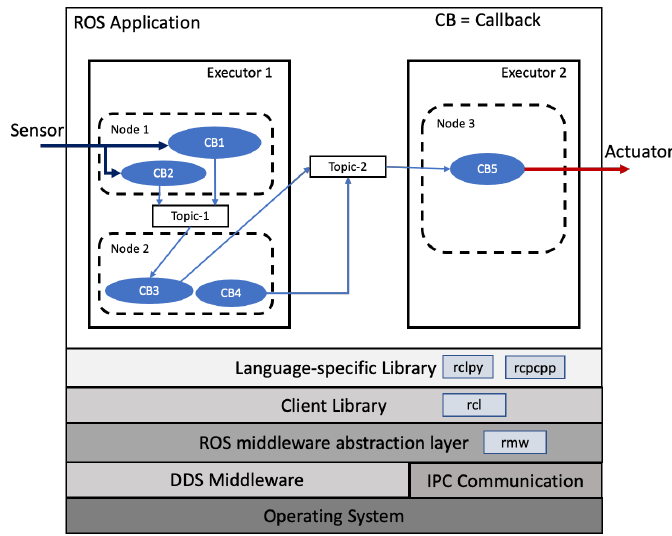
Figure 2. Main concepts of